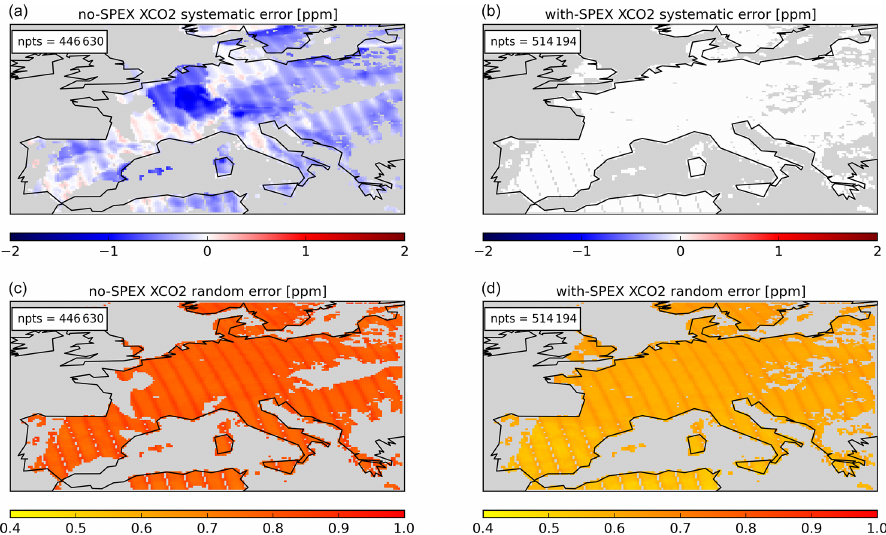
Figure 13. Parameterised X CO systematic (a, b) and random (c, d) errors for 1 July 2015 for the no-SPEX (a, c) and with-SPEX (b, d) design 2 scenario cases and averaged on a 0 . 2 ◦ × 0 . 2 ◦